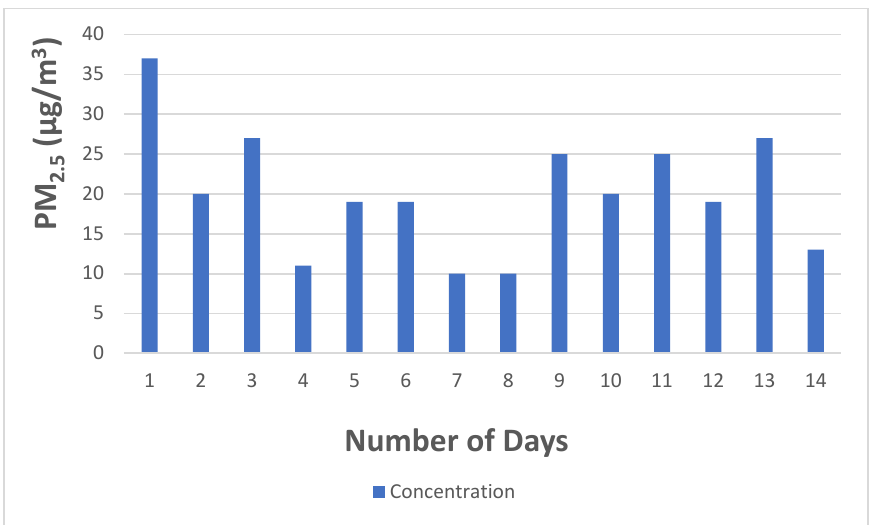
Table 2. Descriptive statistics for PM 2.5 in the renovation area (in μ g/m 3 ).